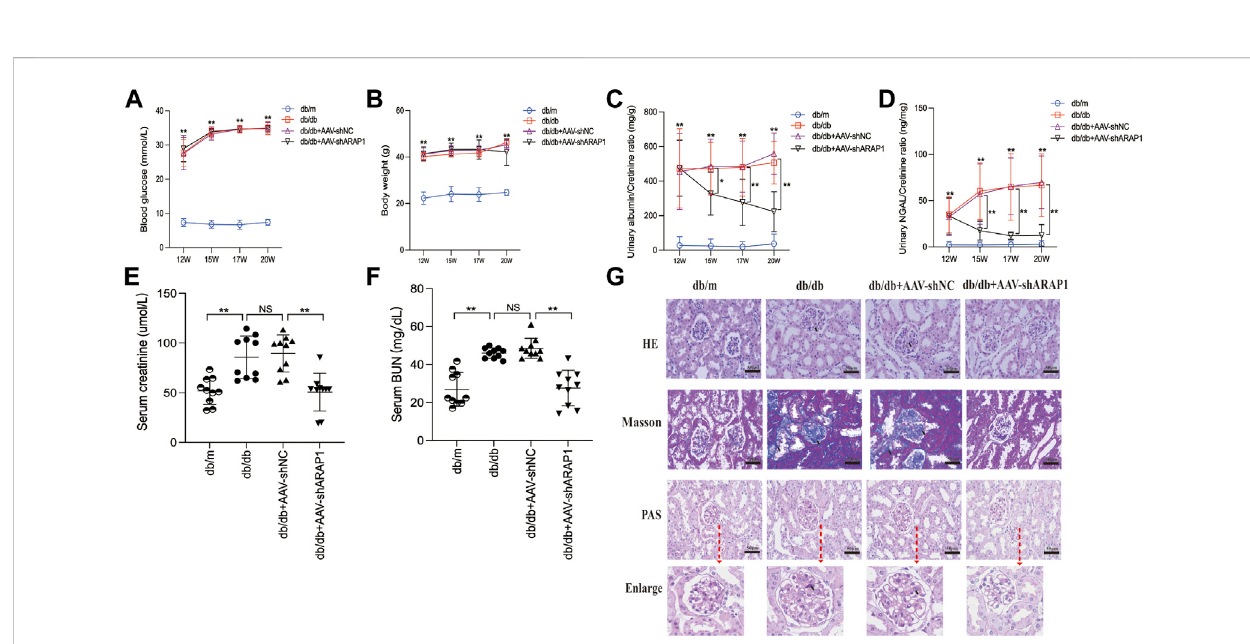
FIGURE 3 ARAP1 knockdown attenuates renal function and tissue injury in the kidneys of diabetic mouse (A) Blood glucose (mmol/L) and (B) body weight (g) wasmeasuredattheindicatedweeks. (C) UrinaryACRatvarioustimepoints(12,15,17and20 weeksofage). (D) UrinaryNgalatvarioustimepoints(12,15, 17 and 20 weeks of age). (E) Serum creatinine at 20 weeks of age. (F) Serum BUN at 20 weeks of age. (G) Representative images of HE, PAS and Masson staining (×400). Bar = 50 μ m. Arrows indicate positive staining. In all panels, the data are representative of at least three independent experiments. Data are presented as the mean ± SD. * p < 0.05, ** p < 0.01, NS, not signi fi